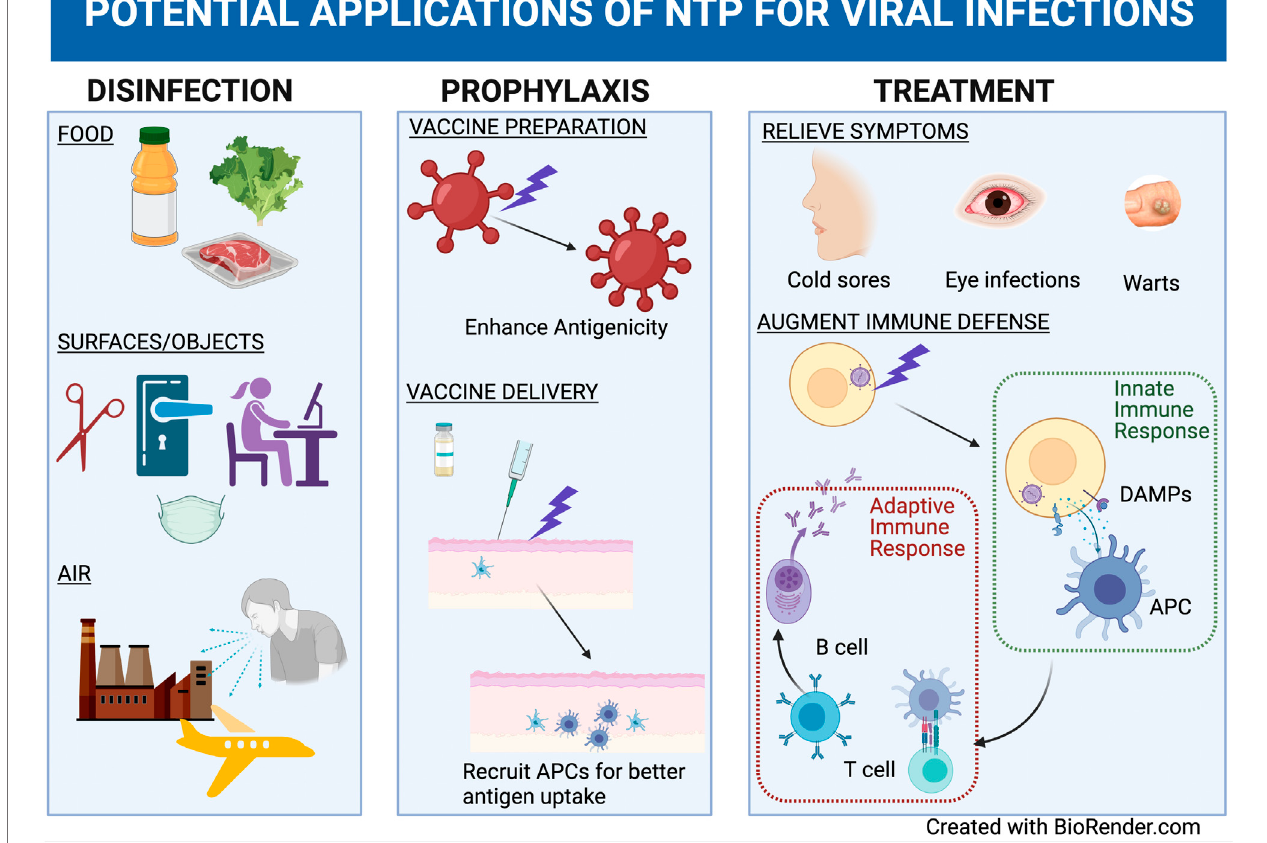
FIGURE 8 | NTP application has potential roles in mitigating virus transmission, in prophylaxis of viral diseases and in treatments of certain focal and systemic viral infections. NTP may be used to prevent virus transmission through disinfection of viruses from food, surfaces/objects, and air. To prevent disease following exposure to viruses, NTP may be used to enhance antigenicity of viruses in vaccine preparations following inactivation or can be applied to skin to promote antigen presenting cell (APC) functionsthatarebene fi cialforvaccination.Treatmentsforvarioussymptomsofviraldiseases suchascoldsoresorwartscanalsoincorporateNTPtoexert antiviral effects and to modulate symptoms. Augmentation of the immune response may be accomplished through stimulation of damage associated molecular pattern (DAMP) emission from NTP-exposed cells, which promotes APC function and a subsequent adaptive immune response.